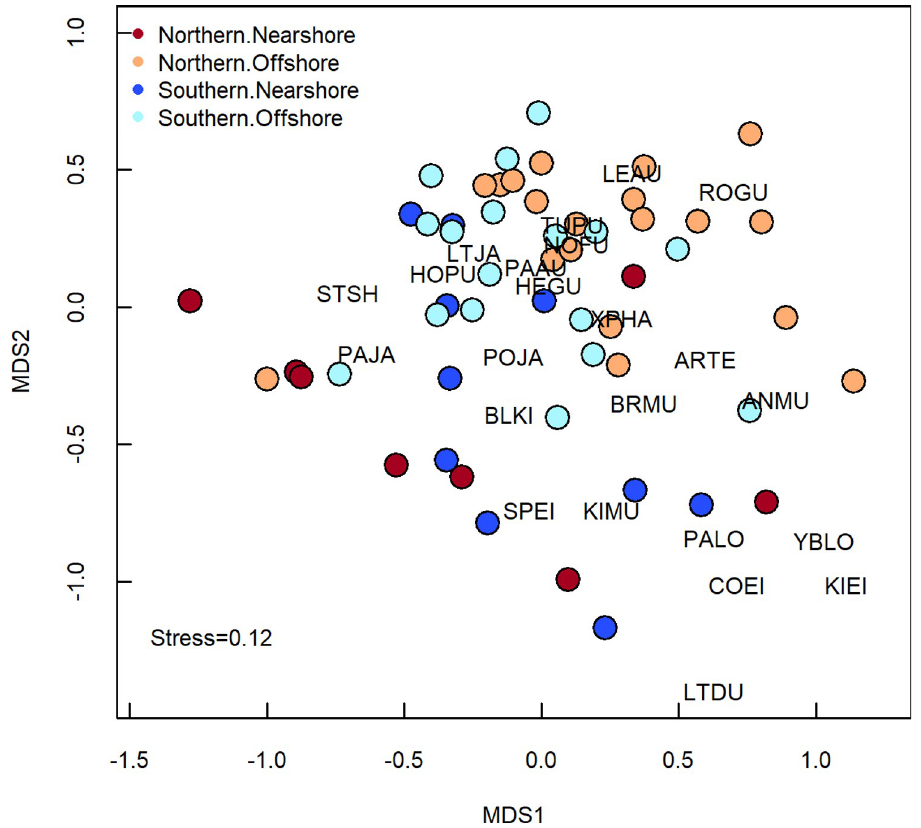
Fig 7. Non-metric multidimensional scaling (nMDS) of the seabird community in the northeastern Chukchi Sea, 2008–2018.